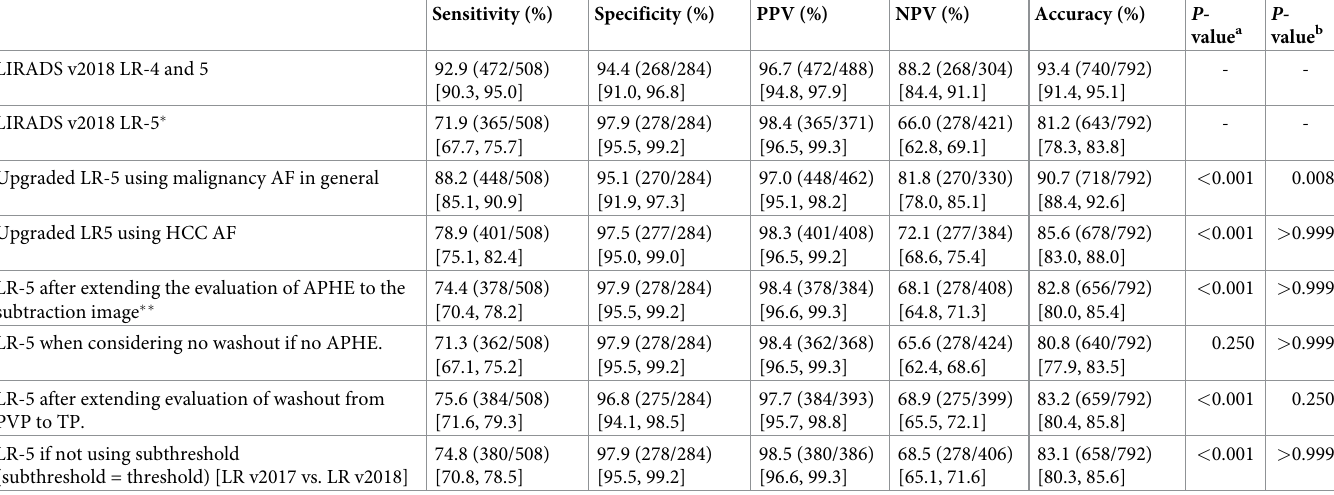
Table 2. Sensitivity, specificity, accuracy, positive predictive value (PPV) and negative predictive value (NPV) of hepatocellular carcinoma (HCC) under various categorizations via LI-RADS v2018.